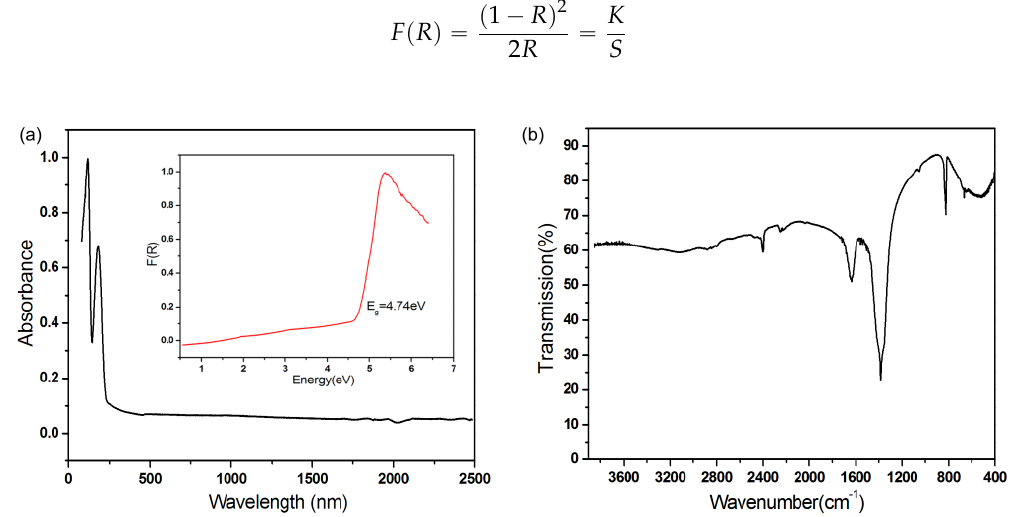
Figure 3. ( a ) UV-vis and ( b ) IR spectra of Rb 2 Na(NO 3 ) 3 .